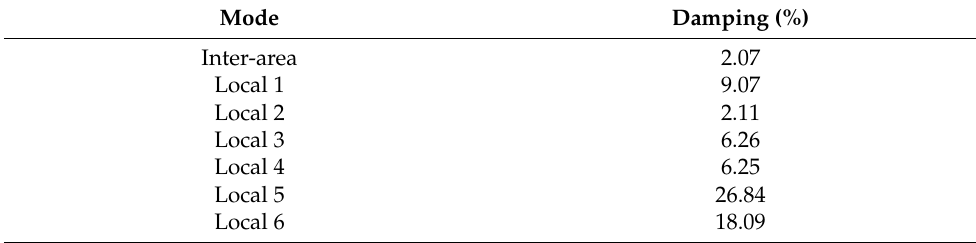
Figure 7. Java Indonesian Power Grid with PV, wind, and BESS. Table 1. Damping value of Java Indonesian power